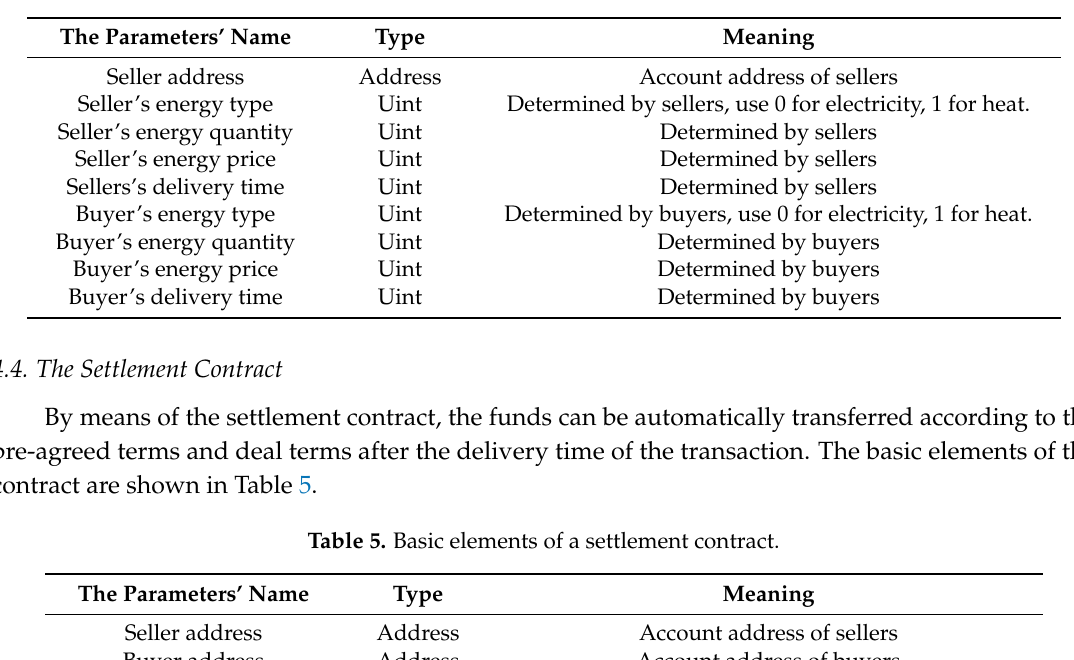
Table 4. Basic elements of a matchmaking trading contract.